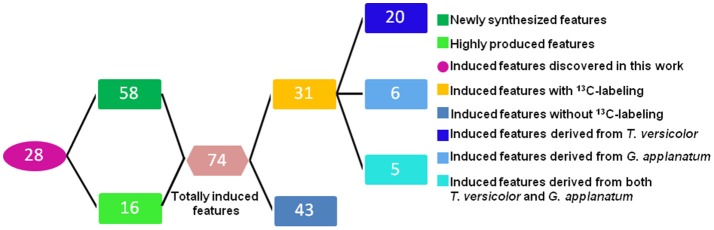
Overview of the number of the induced features in the co-culture of T. versicolor and G. applanatum.